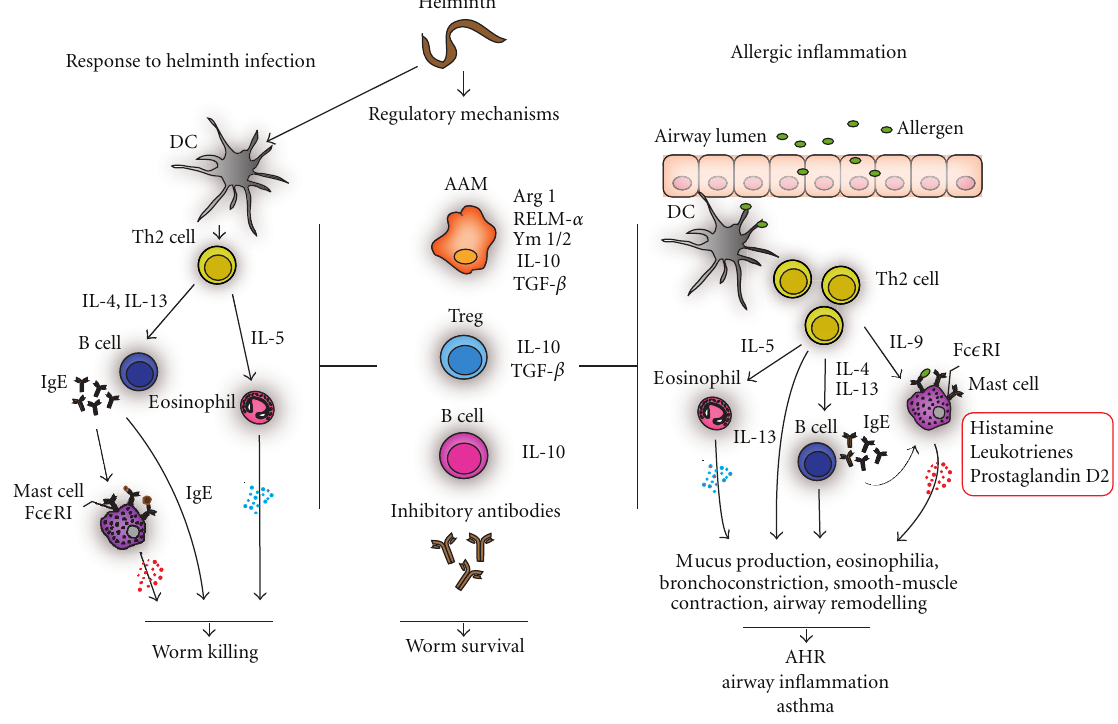
Figure 1: Regulatory and e ff ector mechanisms of Th2-type responses. Th2 immune response in helminth infection : helminth infection induces a protective Th2 immune response. Professional antigen presenting cells such as dendritic cells (DCs) process helminth antigens and display them to CD4 + T cells that di ff erentiate into polarised T helper 2 cells. Th2 cells produce cytokines such as IL-4, -5, and -13 that activate and attract macrophages, eosinophils, and other innate immune cells as well as B cells. IL-4 and -13 induce di ff erentiation of antigen-specific B cells and production of large amounts of antibodies (characteristically IgE). Antibodies opsonise the helminths leading to killing via eosinophils or neutrophils, as well as macrophages by antibody-dependent cellular toxicity (ADCC). IgEs bind to Fc ε -receptors (Fc ε RI) on mast cells (MCs). Sensitized MCs secrete large amounts of histamine and other mediators and facilitate the attraction and accumulation of further immune cells, which result in larvae killing. Regulatory mechanisms in helminth infection: Helminths induce immunoregulation via modulation of immune cells leading to alternatively activated macrophages (AAMs), regulatory T cells (Treg), and B cells. AAMs in mice express among others arginase-1 (Arg 1), resistin-like molecule- α (RELM- α ), Ym-1, Ym-2, IL-10, and TGF- β and contribute to wound healing. Treg produce IL-10 and transforming growth factor- β (TGF- β ), whereas B cells can elicit regulatory mechanisms via IL- 10. These cellular changes lead to modified Th2 immune responses and larvae survival as well as blocking of unrelated inflammation such as allergic immune responses. Allergic inflammation: DCs present allergen-derived peptides to T cells. Stimulation of allergen-specific T cells results in di ff erentiation of CD4 + T cells into Th2 cells that produce Th2 cytokines. IL-4 directs T cell di ff erentiation towards a Th2-related phenotype. IL-5 regulates the recruitment and di ff erentiation of eosinophils and stimulates them to release mediators. Additionally, IL-4 and -13 induce Ig-class switching to IgE by B cells. IgEs bind to high a ffi nity Fc ε RI on MCs. Sensitized, IL-9-activated, and maturated MCs degranulate and release preformed mediators, including histamine, leukotrienes, and prostaglandins. This allergic inflammatory cascade leads to increased mucus production, eosinophilia, bronchoconstriction, smooth-muscle contraction, and remodelling in the lungs, which result in allergic-airway hyperreactivity (AHR), airway inflammation or asthma. The allergic inflammation may be suppressed by a spill-over e ff ect of immunomodulatory mechanisms of helminth